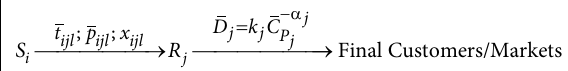
Figure 3. Initial manner of the supply